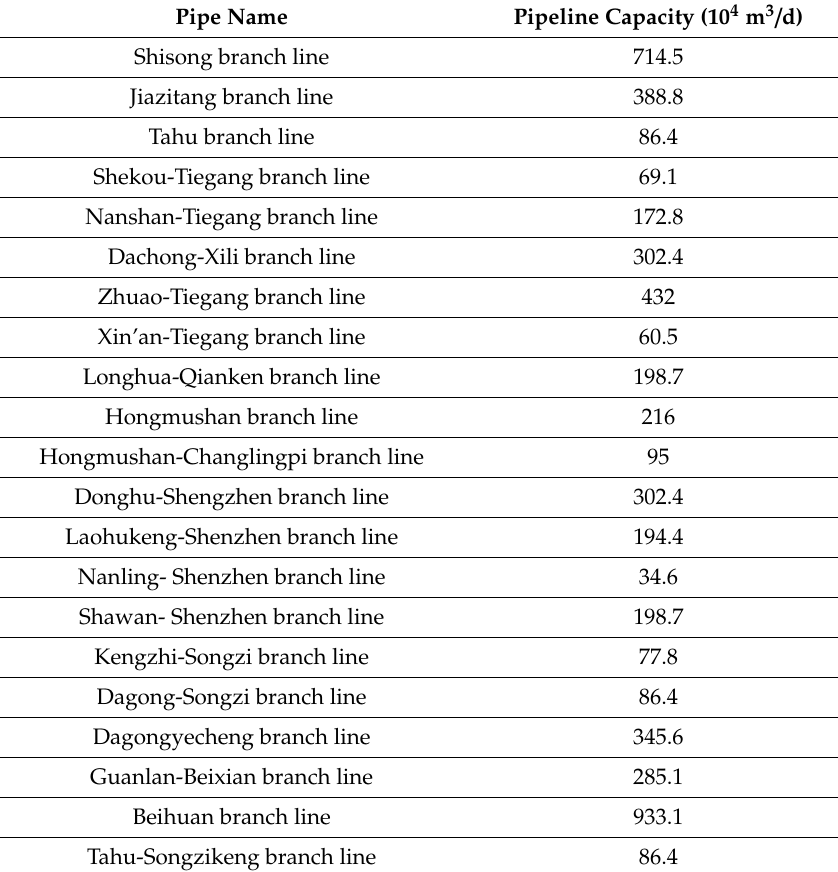
Table 4. The maximum capacity values of the main pipelines in this